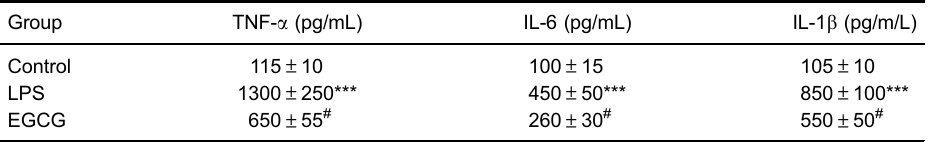
Data are reported as means ± SE. Control group: mice were given saline; LPS group: mice were given